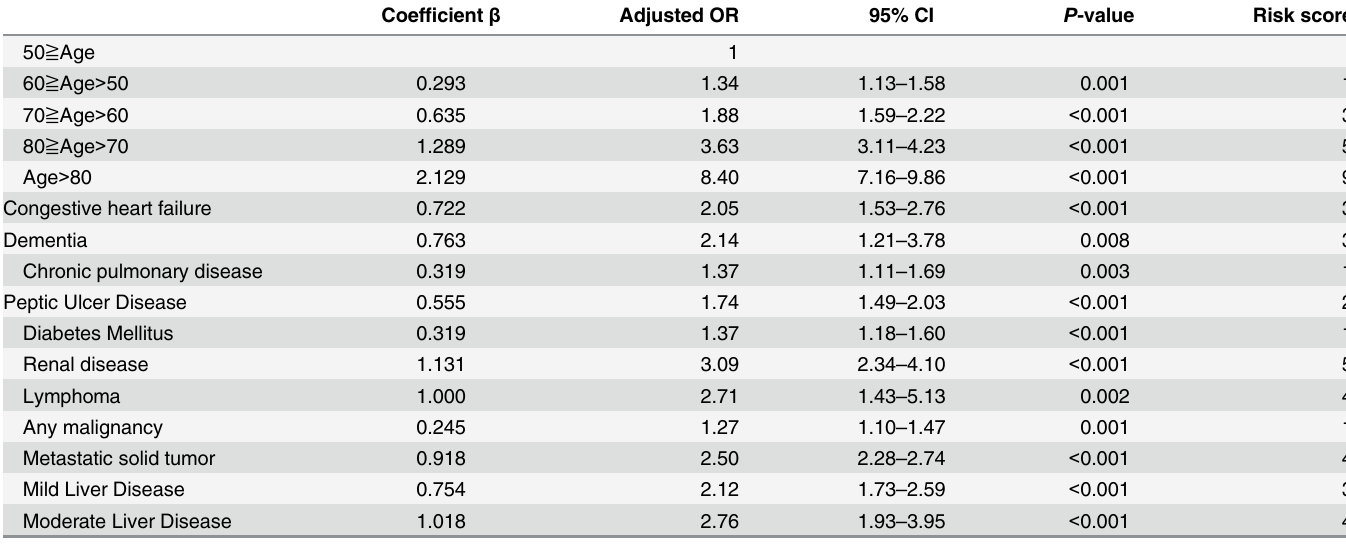
Table 2. Development of the predictor score based on multivariate logistic regression analysis of the derivation set, n =